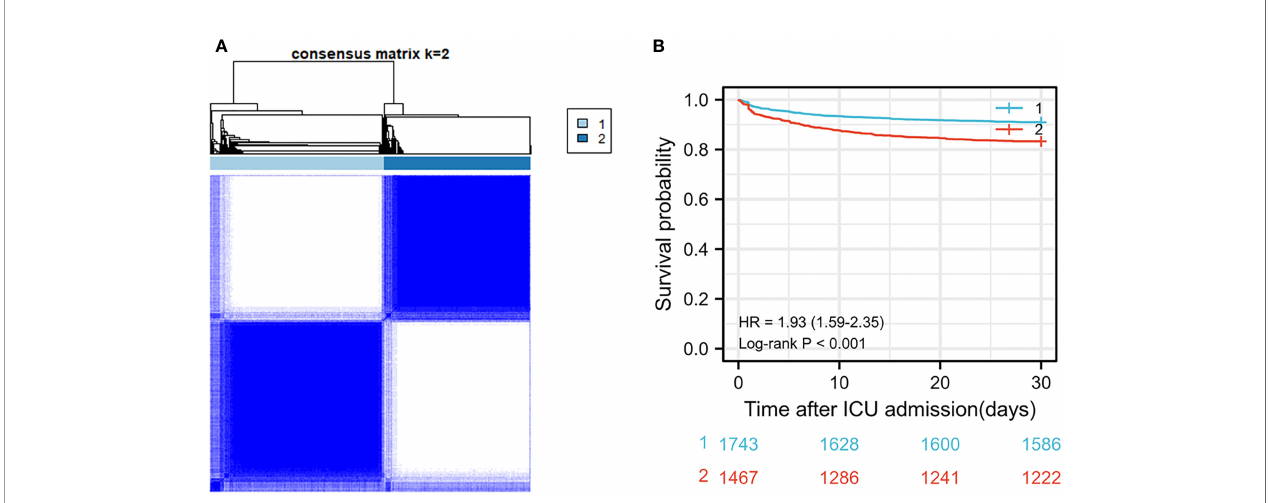
FIGURE 2 | (A) Cluster diagram in MIMIC-IV population. (B) Survival curve between two clusters of patients in MIMIC-IV